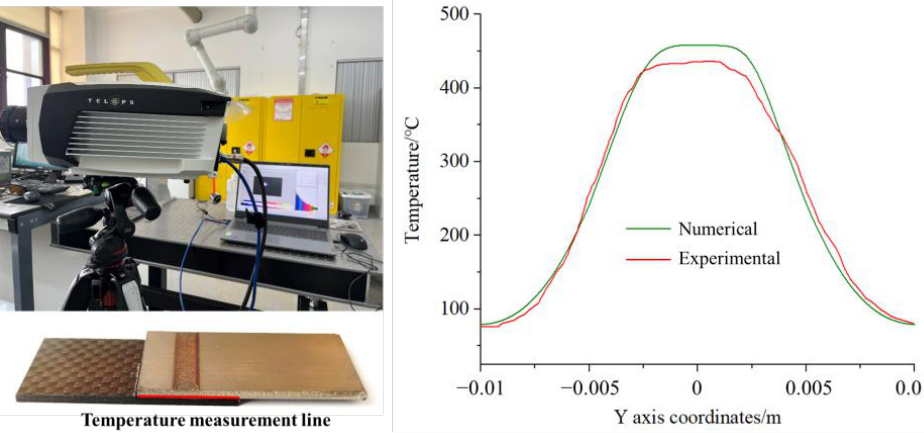
Figure 13. Comparison between experimental results and finite element simulation results.